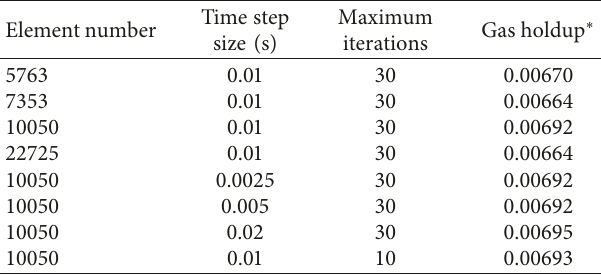
Table 2: Global gas holdup with different parameters.